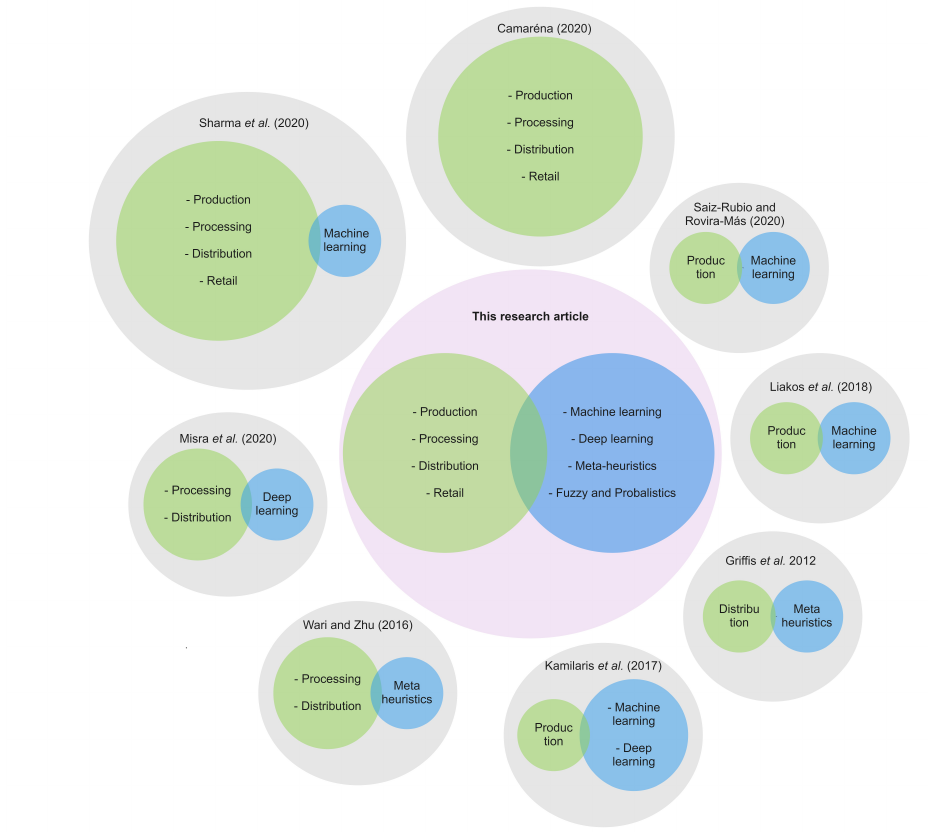
Figure 3. Motivations and state-of-the-art concepts at the point where FSC and CI